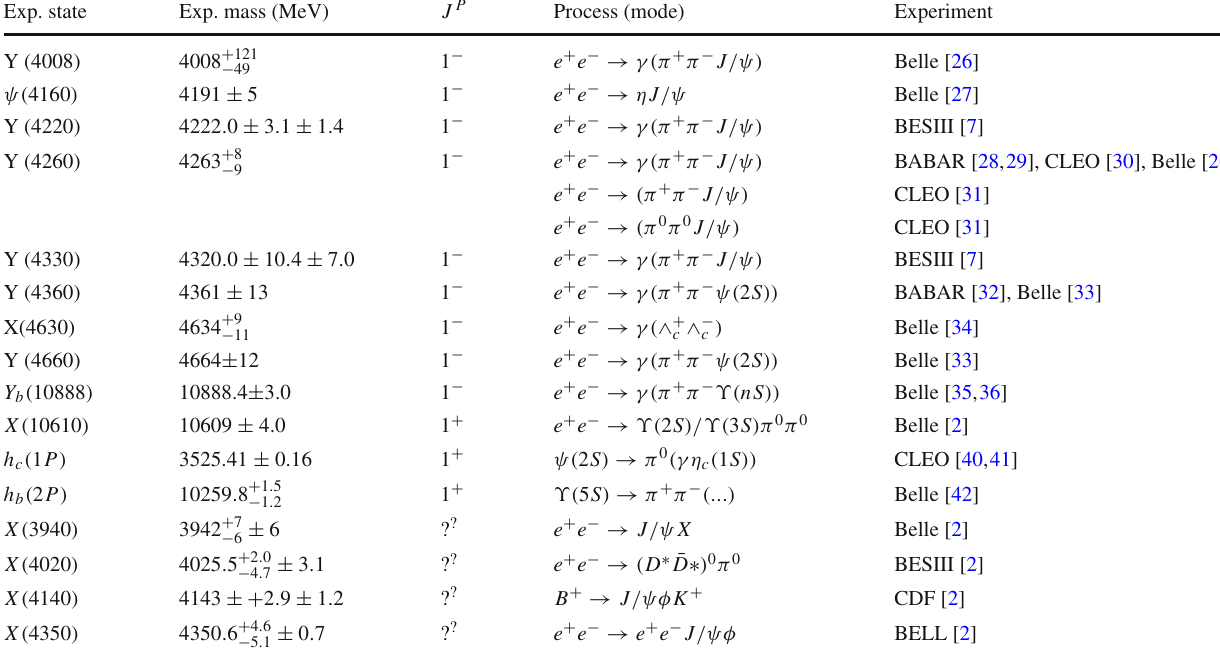
Table 1 Experimental status of some of the negative parity and positive parity quarkonia-like states Exp.